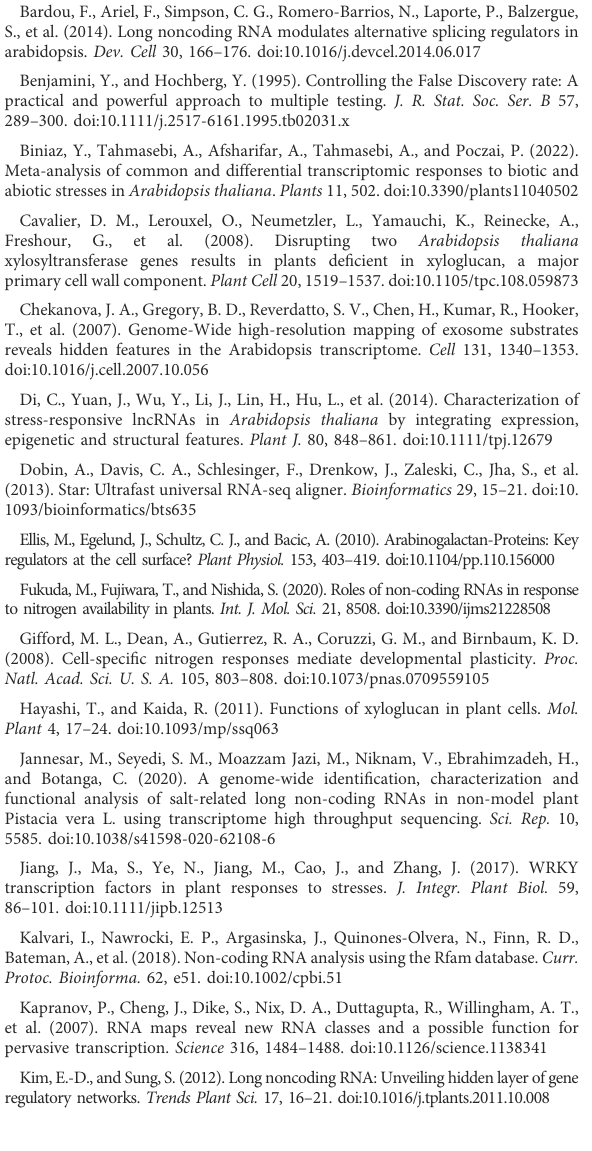
Results from the co-expression analysis performed among differentially expressed genes long noncoding RNA (DElncRNAs) and differentially expressed protein-coding genes (DE PCGs) for GSNO-